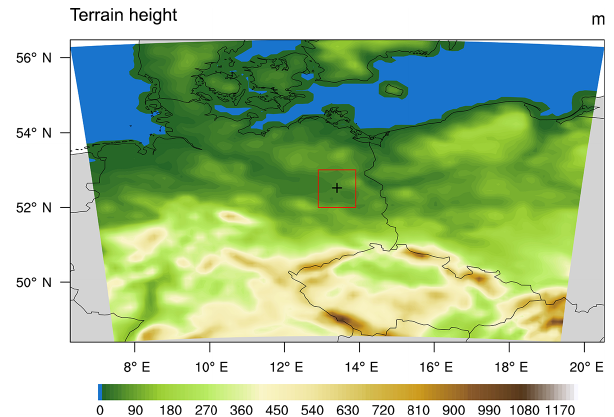
Figure 1. The Berlin-centred WRF-GHG model domain in Lam- bert conformal conic projection used in the study. The red rectan- gle represents the target region (100km × 100km) described in the Sect. 3.2 and the + sign indicates the central location of Berlin. The colour bar indicates the terrain height in